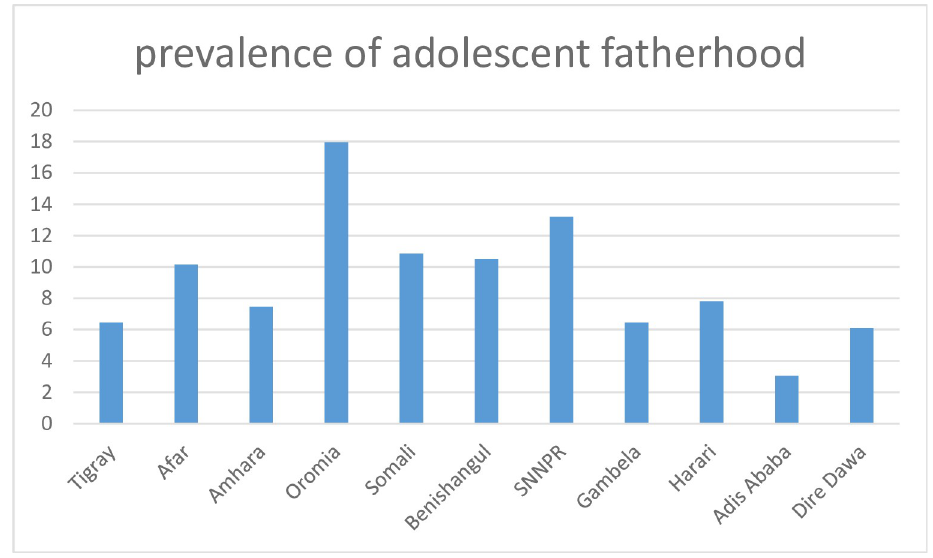
Fig 1. Prevalence of adolescent fatherhood by region.